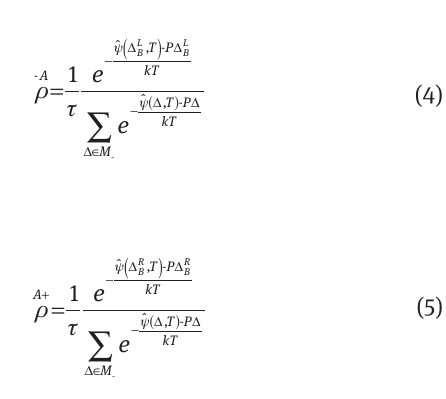
αβ ρ The quantities in (2) and (3) are the transition proba- bilities from phase α to phase β and are calculated using statistical thermodynamics. They are determined by the ( T P where Δ Boltzman factor corresponding to B B are shear lengths at the barriers of the effective potential energy (see Figure 14D). These quantities may then be given